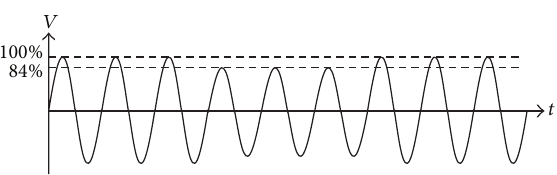
Figure 13: Characteristic of waveform injection into the system.